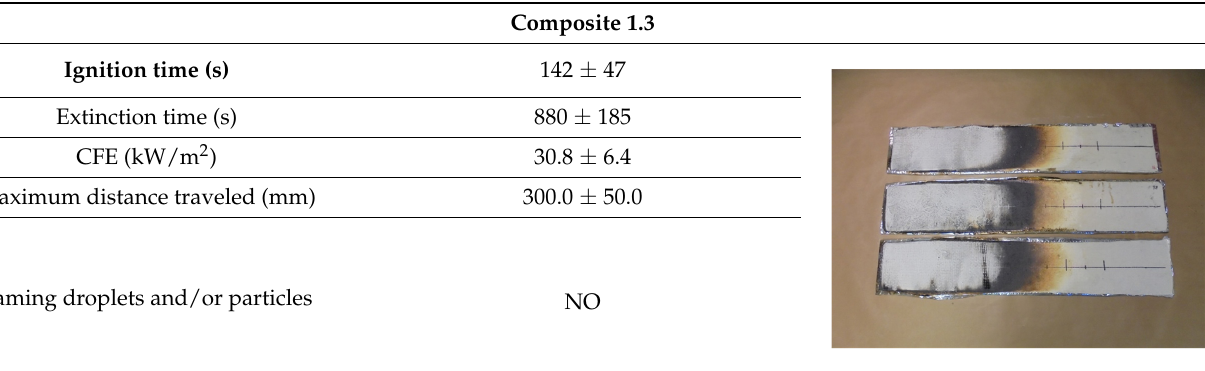
Table 8. Lateral flame propagation of composite 1.3 and images of tested specimens.